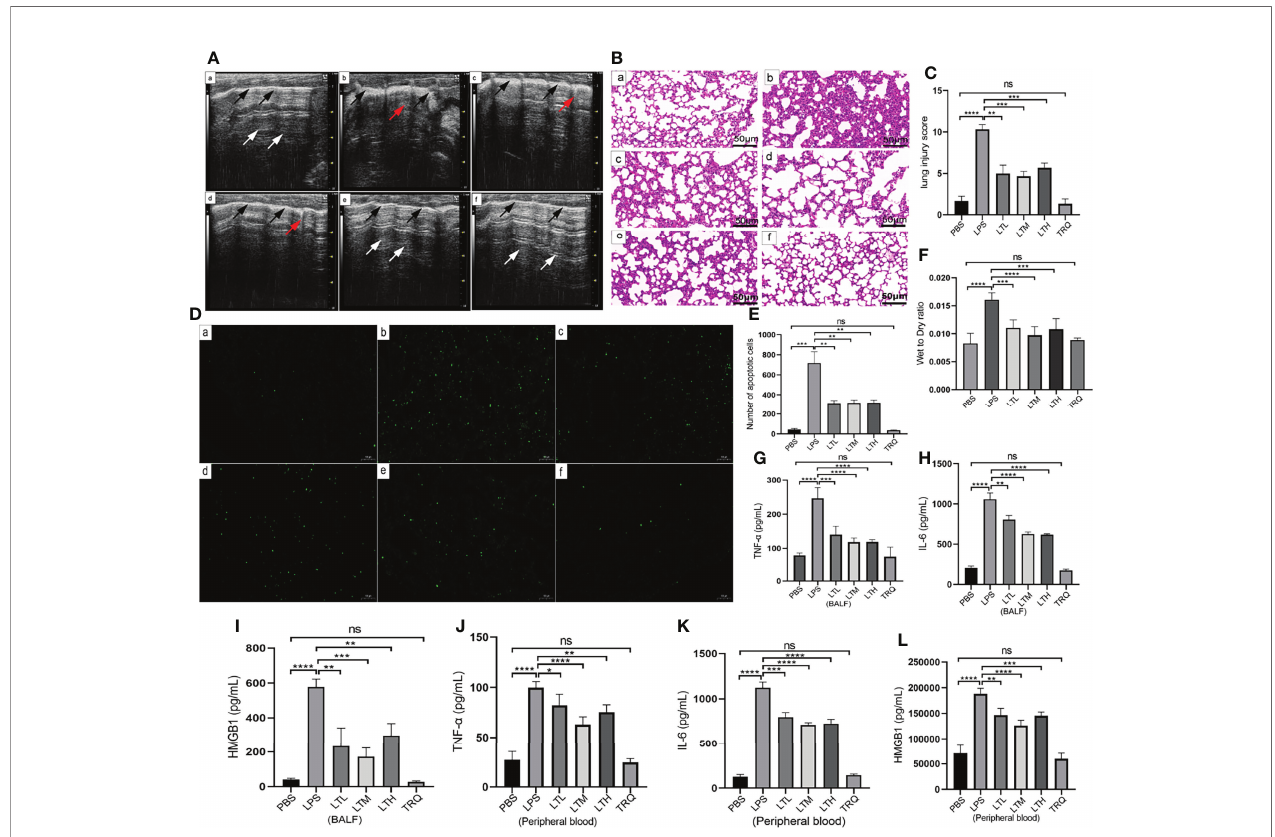
FIGURE 8 | TRQ mitigates LPS-induced ALI. (A) Ultrasound imaging was performed to assess lung injury in the control (a) , LPS (b) , LTL (c) , LTM(d), LTH (e) and TRQ (f) groups. (B) HE staining was performed to assess lung injury in the control (a) , LPS (b) , LTL (c) , LTM (d) , LTH (e) and TRQ (f) groups (magni fi cation, ×200, scale bar, 50 m m). (C) The lung injury score of HE staining. (D) The TUNEL apoptosis assay of lung tissue in the control (a) , LPS (b) , LTL (c) , LTM (d) , LTH (e) and TRQ (f) groups (magni fi cation, ×100, scale bar, 100 m m). (E) The apoptosis cells number of lung tissue. (F) The wet/dry weight ratio of right upper lung tissue in the control, LPS, LTL, LTM, LTH and TRQ groups. (G – I) Expression of proin fl ammatory cytokines (TNF- a , IL-6 and HMGB1) in the BALF, as determined by ELISA. (J – L) Expression of proin fl ammatory cytokines (TNF- a , IL-6 and HMGB1) in the peripheral blood supernatant, as determined by ELISA. Data are indicated as the mean